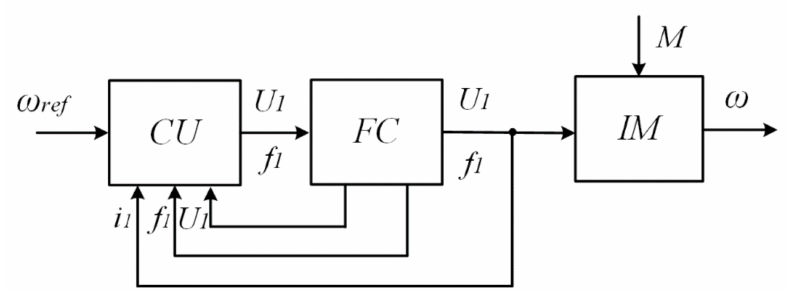
Figure 2. Block diagram of an asynchronous electric drive with scalar and vector sensorless control. CU, control unit; FC, frequency converter; IM, induction motor.